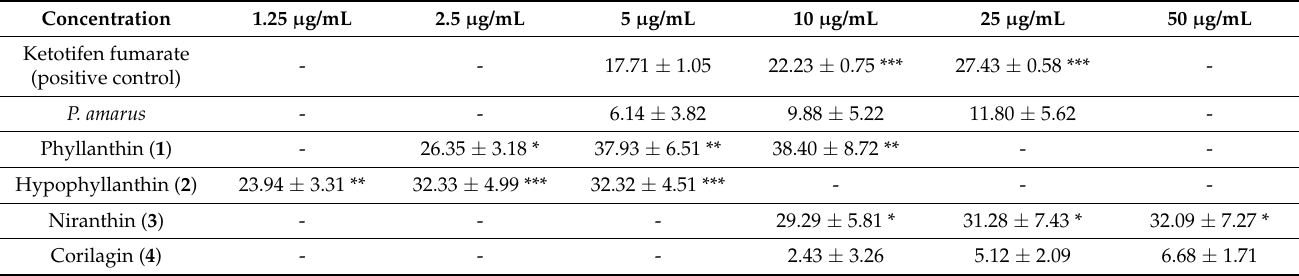
Table 6. Inhibitory activity towards the beta-hexosaminidase release of P. amarus extract and its compounds.